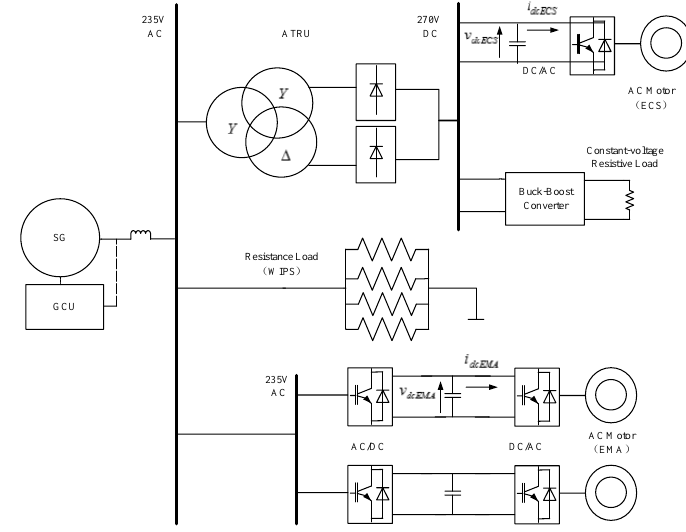
Figure 1. Typical structure of most electric aircraft.